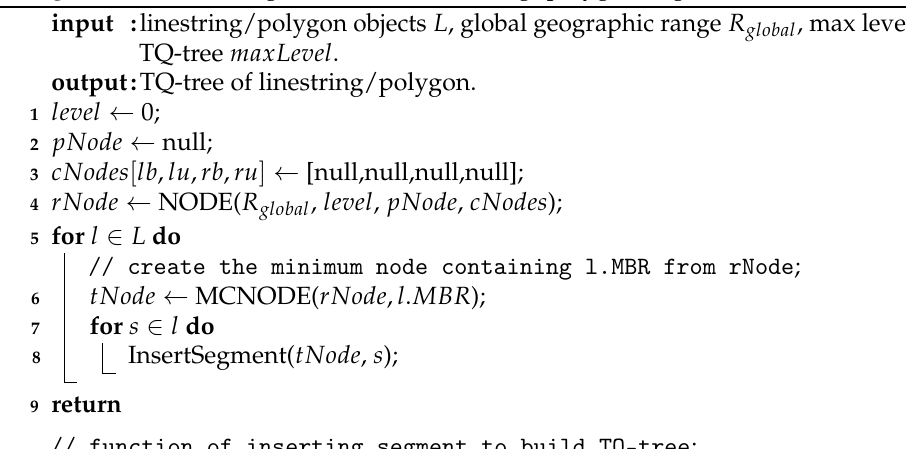
Algorithm 2: TQ-tree generation for linestring/polygon